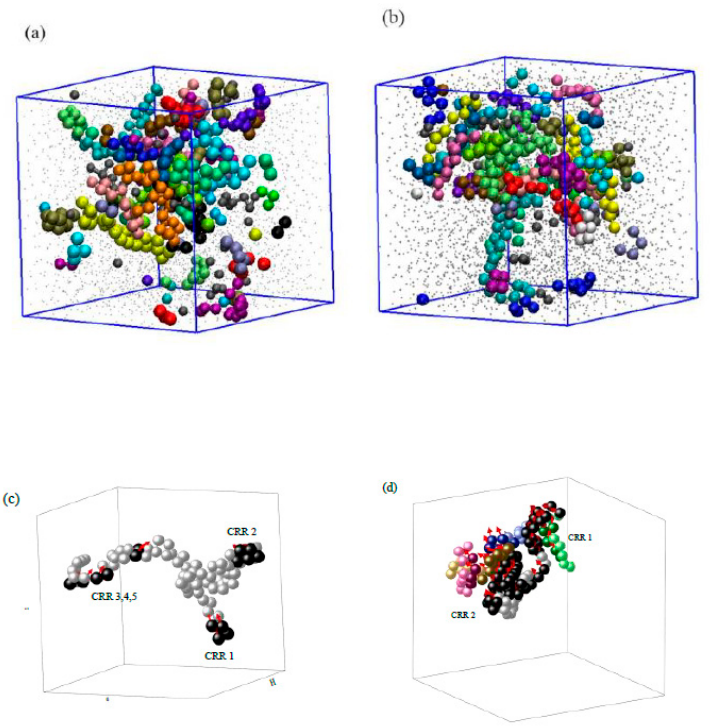
Figure 7. Snapshots of cooperatively rearranging PS monomers. ( a ) and ( b ) The overall snapshots at T = 0.45 and T = 0.42, respectively. The larger colorful monomers were drawn to scale and represent the 10% fastest ones, different colors represent different chains. The rest of the monomers are shown as small grey dots. Because of periodical boundary conditions, some of the monomers close to the boundary look to be isolated. ( c ) and ( d ) Typical CRRs at T = 0.45 (CRR1 to CRR5) and T = 0.42 (CRR1 and CRR2), respectively. Different colors mean different chains. Deep colors mean 10% fast monomers, and the light ones mean the rest of the monomers in the same chain. The red arrow shows their moving direction during 0.99 μ s at T = 0.45 and 4.60 μ s at T = 0.42.